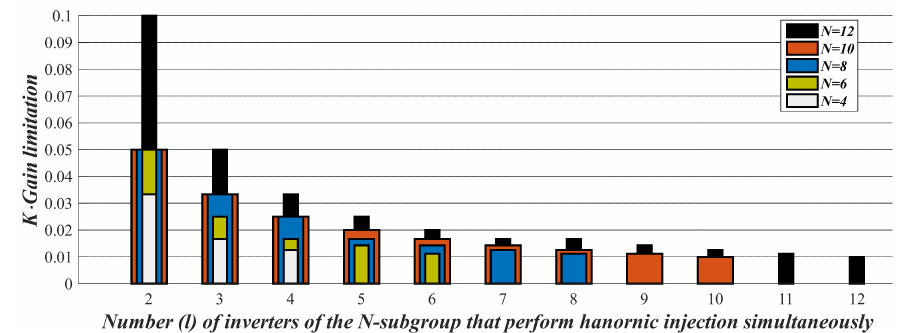
Figure 7. K · Gain limitation as a function of l , for five indicative N -values (i.e., N = 4, 6, 8, 10, 12).